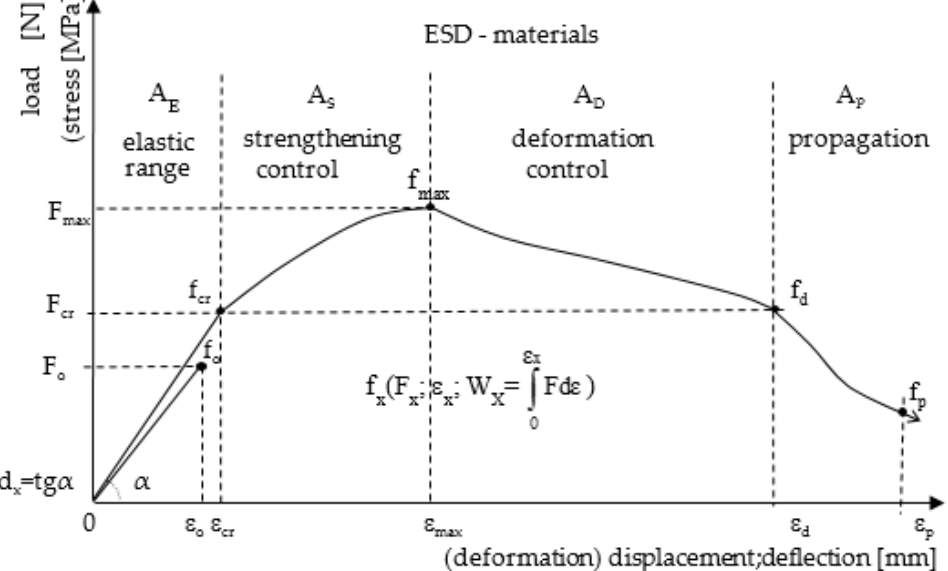
Figure 3. ESD composites depending on load deflection. Areas: A E , elastic range; A S , strengthening control; A D , deflection control; A P , propagation.